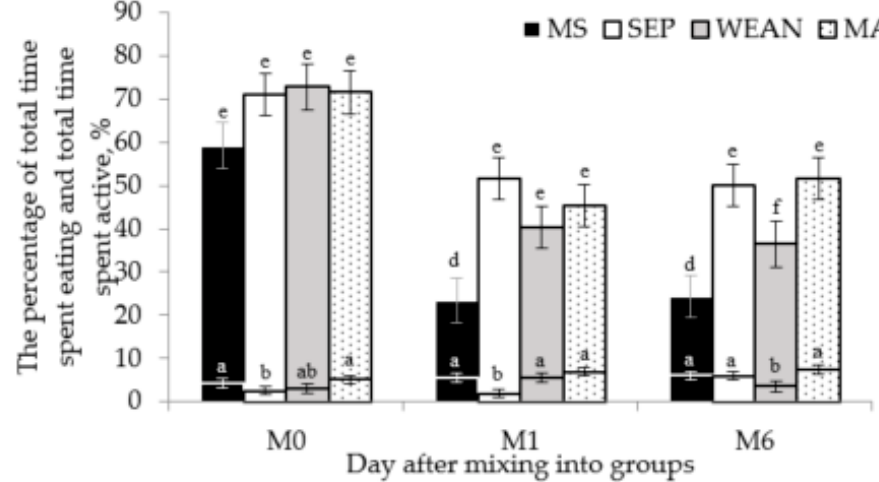
Figure 3. Percentage of time spent eating (lower bars) and active (upper bars) in the days after mixing 1,2 . a,b,c, Means with different superscripts differ (p < 0.05). d,e,f Means with different superscripts differ ( p < 0.05). 1 SEP: sow separation from crates and litters for seven hours daily (by mixing into a group pen and later returning to their crates and litters, MS; group-housed sows and litters (multisuckle) from day 21 lactation, WEAN; sows mixed after weaning at day 28 lactation, MAI; sows mixed after their post-weaning AI (4 ± 1 days after the last insemination). 2 Non-transformed and adjusted data are presented, the original transformation used for analysis of this data is the Sqrt